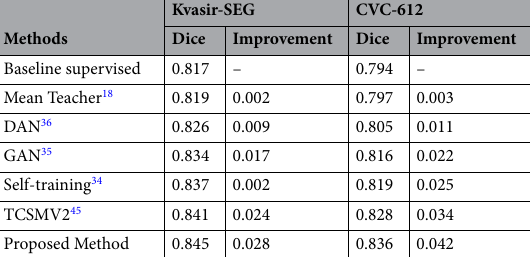
Table 4. Comparison of different semi-supervised methods performance in Dice coefficient